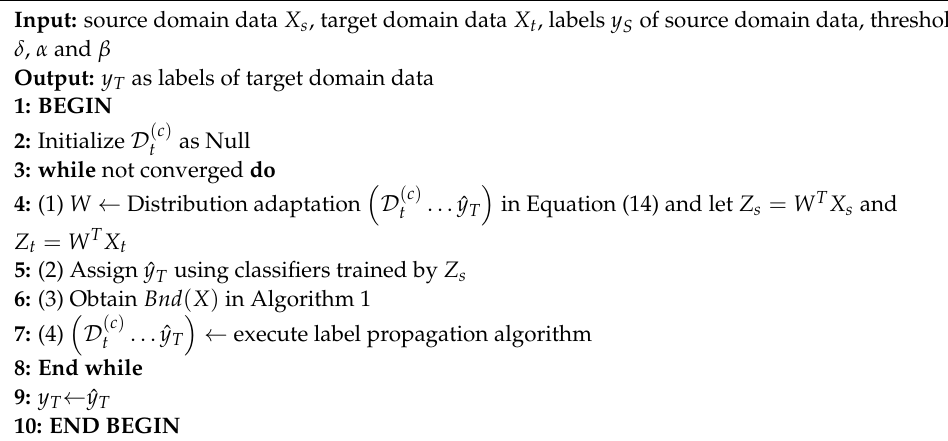
Algorithm 2 Our Proposed